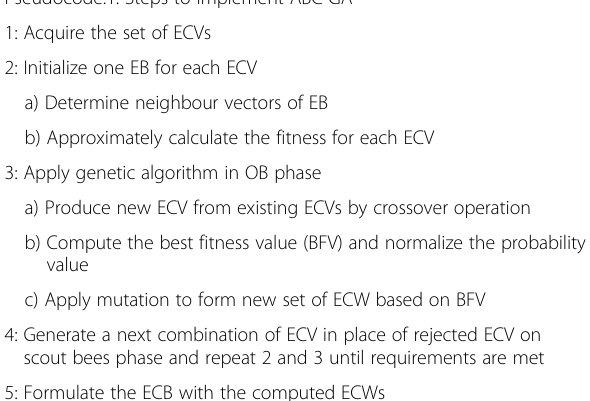
Pseudocode.1. Steps to implement